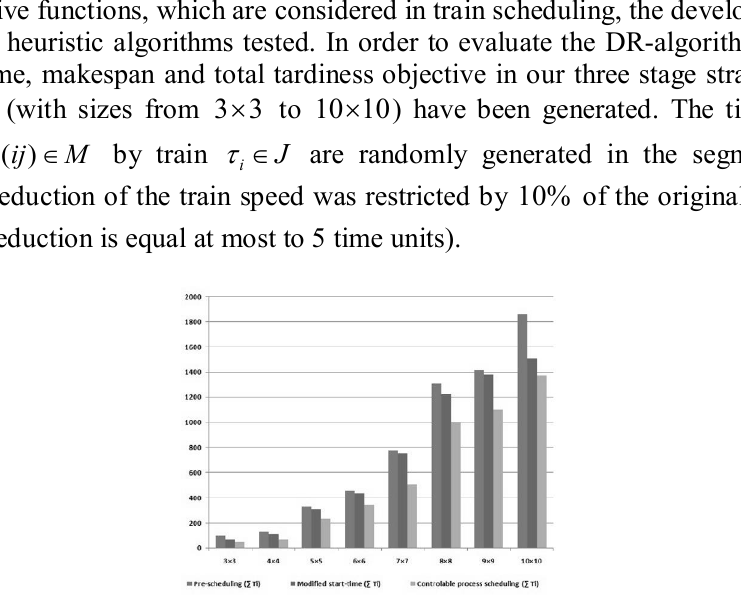
Fig. 6. The total tardiness of the trains after each of three